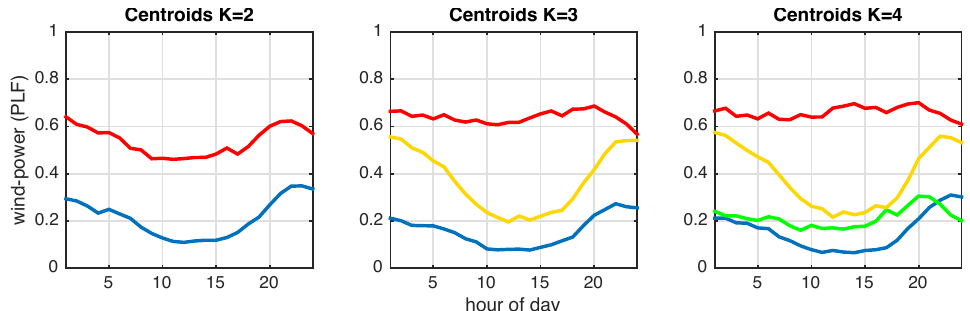
Figure 6. Centroids of actual wind-power samples for different number of